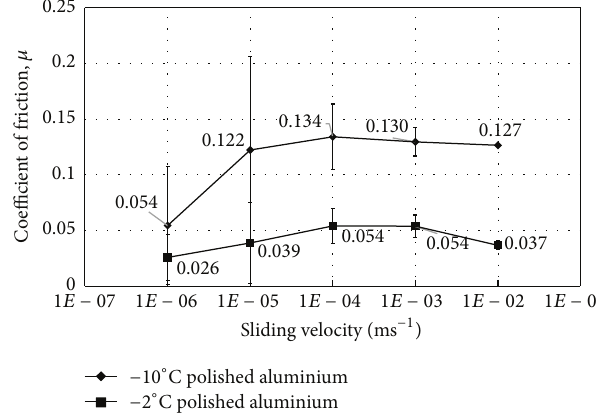
Figure 11: Friction as a function of sliding speed for ice on alu- minium,showingresultsforpolishedaluminiumat − 10 ∘ Cand − 2 ∘ C. The data compared herearealso shown separately in Figures 8 and